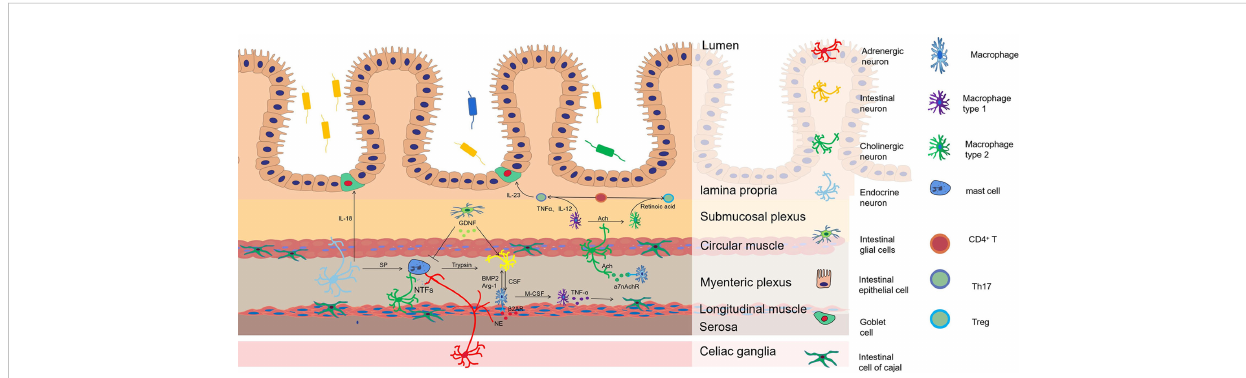
FIGURE 1 The mechanism of neuroimmune regulation in HAEC. Macrophages are the main source of bone morphogenetic protein 2 (BMP2), which stimulate intestinal neurons to regulate gastrointestinal motility. In turn, the development and reproduction of Macrophages are controlled by colony stimulating factor (CSF1) expressed by intestinal neurons. Adrenergic nerve fi bers regulate muscular macrophages to participate in the protection of neurons by acting on b 2AR. Cholinergic nerve fi bers regulate the conversion of macrophages from M1 to M2 to inhibit the development of in fl ammation by acting on a7nAchR, which increases the ratio of Treg/Th17 in intestinal mucosa. M1 macrophages release TNF- a that makes cells of Cajal lose the c-kit phenotype and causes intestinal motility disorder. In the aganglionic segment of colon in patient with HSCR, mast cells release neurotrophic factors (NTFs) to promote the proliferation and hypertrophy of nerve fi bers. SP from peptidergic neurons promotes mast cells degranulation, resulting in releasing of pro-in fl ammatory mediators such as TNF- a , IL-1 b and trypsin, inducing neuronal injury. GDNF from EGCs can signi fi cantly inhibit mast cell degranulation and reduce in fl ammation. A sharp arrow indicates functional promotion, while a fl at arrow indicates